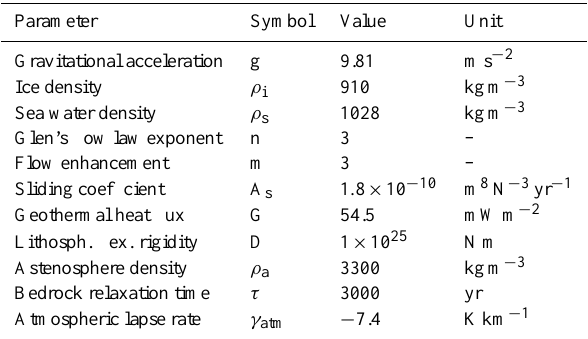
Table 1. Ice sheet model parameter